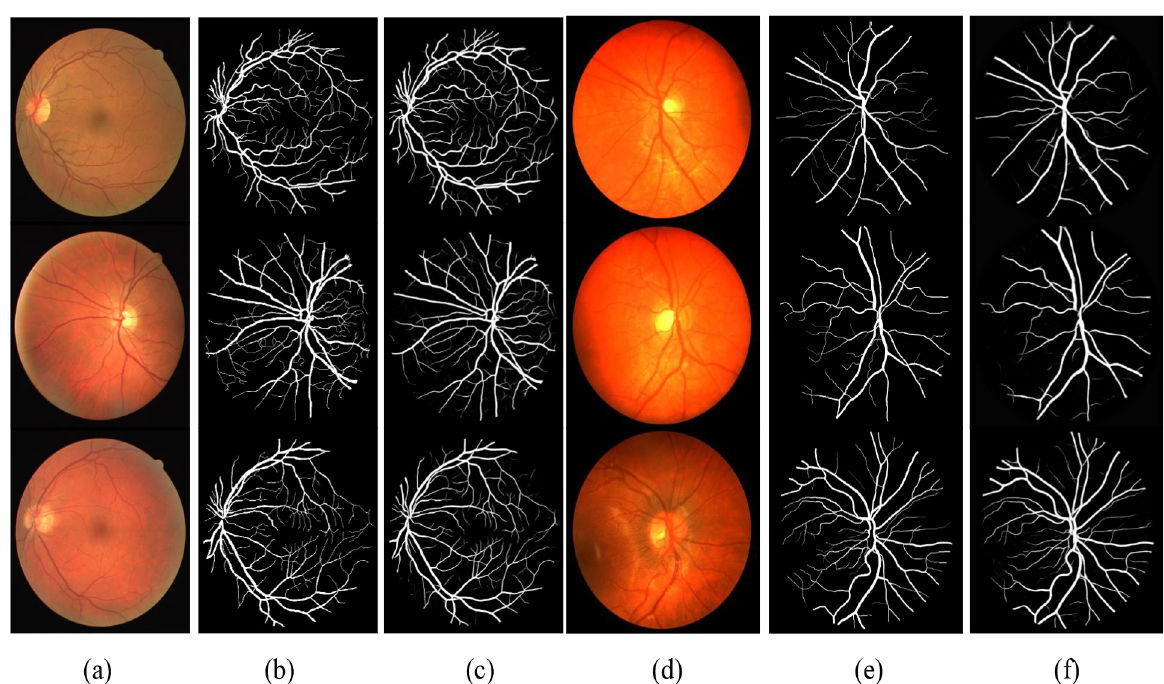
Fig 3. Some examples from two experiments on the DRIVE and CHASE DB1 datasets. The first three columns are from the DRIVE dataset. The last three columns are from the CHASE DB1 datasets. (a) and (d) Color fundus image, (b) and (e) ground truth, (c) and (f)